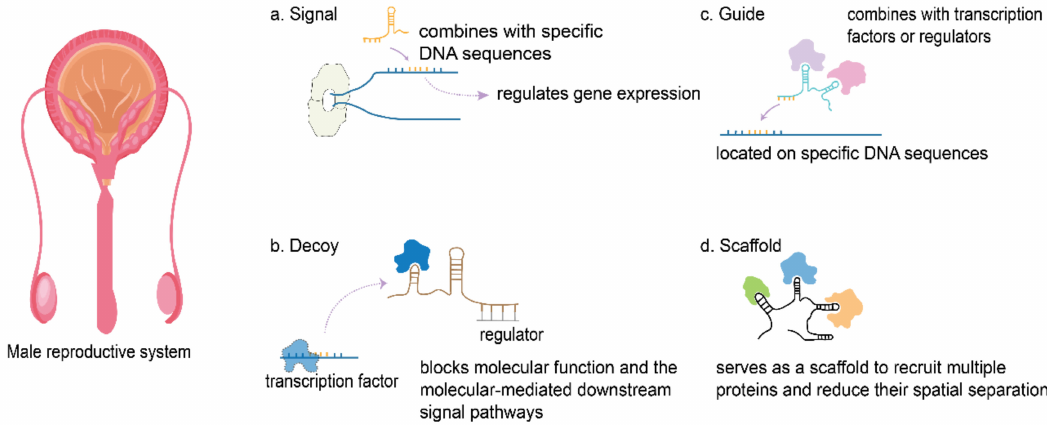
Figure 2. Classification of long noncoding RNAs (lncRNAs) according to their mode of